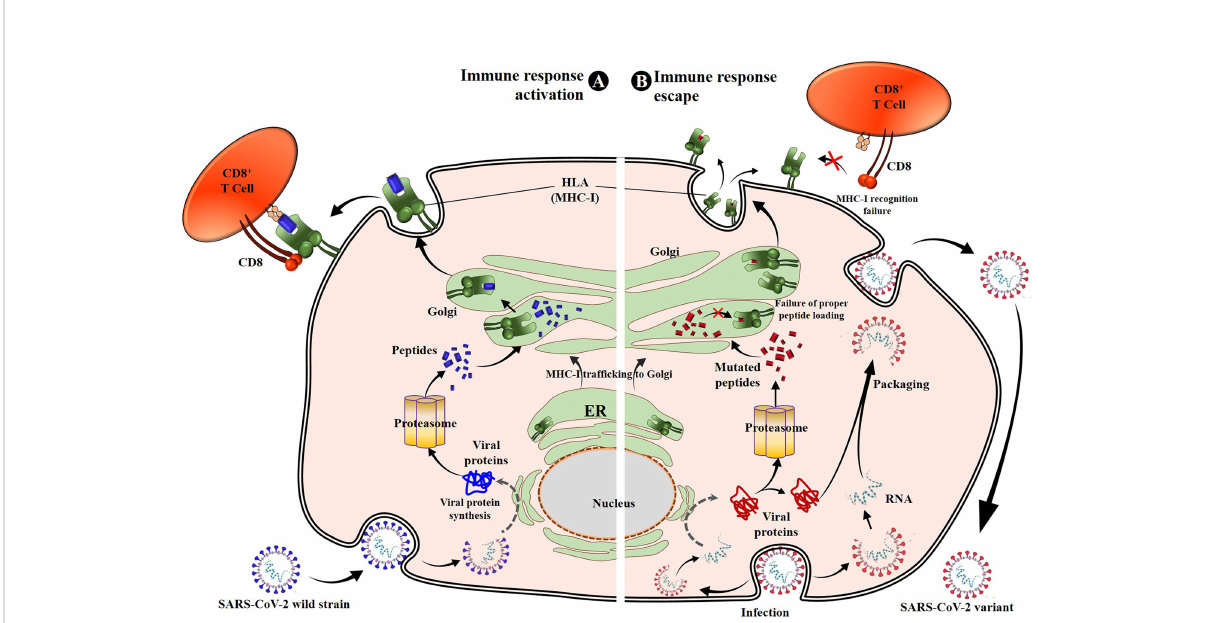
FIGURE 4 SARS-CoV-2 S protein mutations prevent cellular immunity activation. Once entered into the target cell, SARS-CoV-2 releases its genomic RNA, which serves to produce the viral proteins, including structural and nonstructural proteins. Recognized as non-self-molecules, antigen processing and presentation pathways occur for viral protein lysis into peptides that are then loaded onto the MHC-I or HLA molecules and presented to CD8 + CTLs, activating the cell cytotoxic response. The CD8 + T cells produce numerous toxic substances (perforins, granzyme, and FasL) and cytokines (IFN- g , TNF- a , and IL-2) directly involved in SARS-CoV-2 – infected cell death (A) (30, 32). However, because of the mutations in speci fi c antigen peptides (such as spike-mutated derived antigens), these later lose their binding af fi nity to HLA-I. Consequently, the peptides are either not loaded or unstably loaded onto the corresponding HLA molecules. This leads to the reduction or non-activation of the CD8 + T cells through low af fi nity or absence of HLA-I-peptide recognition by TCR, resulting in cellular immune escape and infection maintenance by SARS-CoV-2 variants (B) . MHC-I, major histocompatibility complex type I; CTL, cytotoxic T